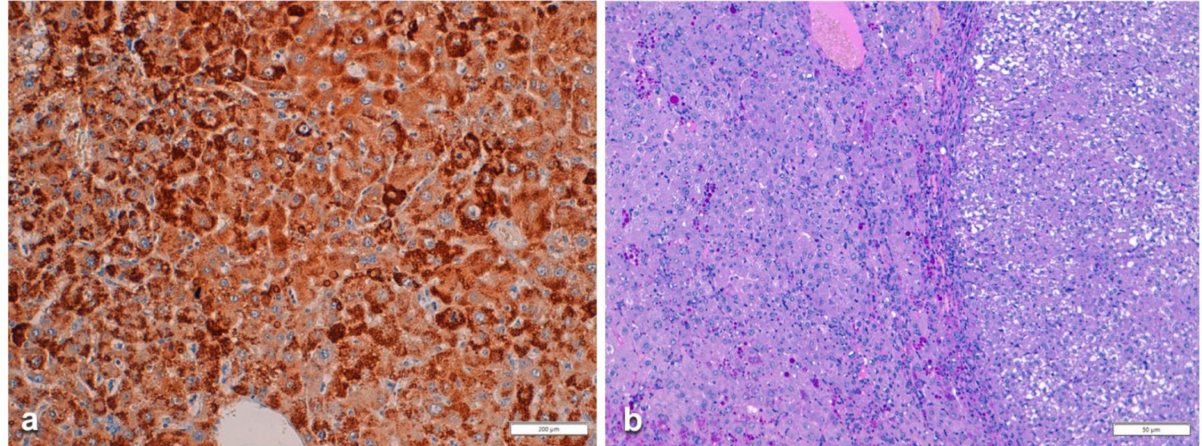
Figure 18. Histological sections from a Pi Z mouse liver. All hepatocytes from the non-tumorous tissue are stained positively for AAT. The positivity is mainly of type I. However, type II positivity is present in the deep part of the lobule ( a ) (Z AAT immunostaining × 100). In Figure b a well demarcated tumor nodule is present. Tumorous hepatocytes are devoid of PAS-D globules, that are observed in the non-tumorous tissue in the left part of the section ( b ) (PASD staining ×